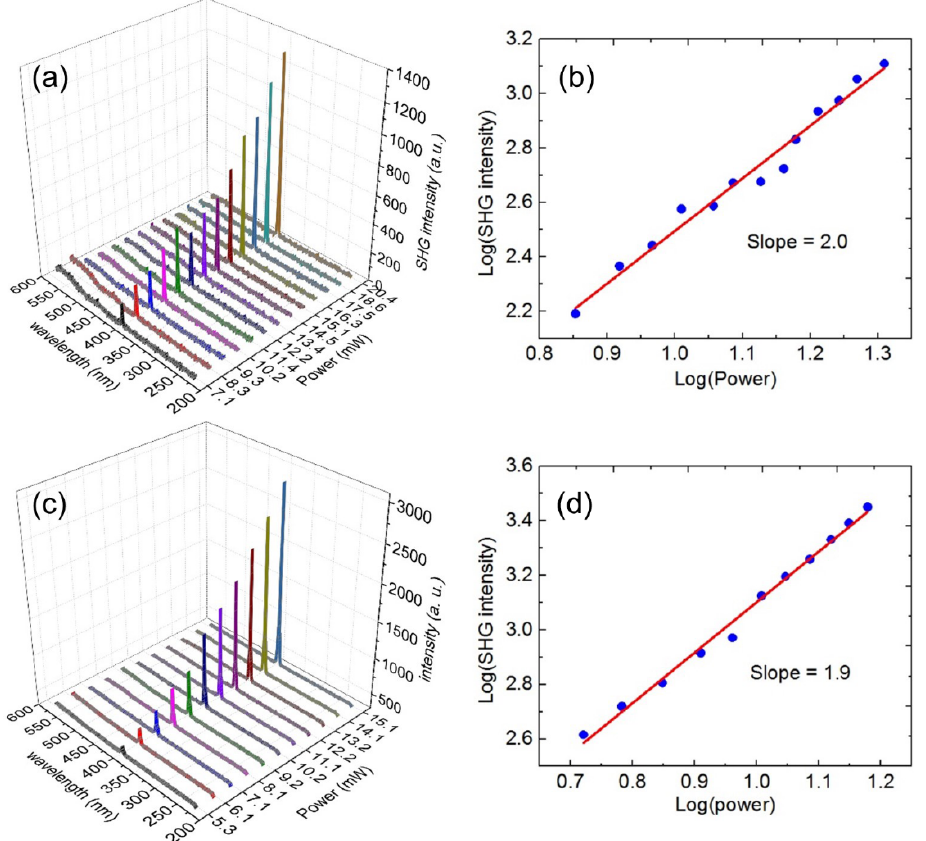
Figure 6. ( a ) SHG spectra at different excitation powers and ( b ) SHG intensity vs. excitation power in a logarithmic scale for the vertical Au nanorod array with a diameters of 22 nm; ( c ) SHG spectra at different excitation powers and ( d ) SHG intensity vs. excitation power in a logarithmic scale for the vertical Au nanorod array with a diameters of 41 nm.